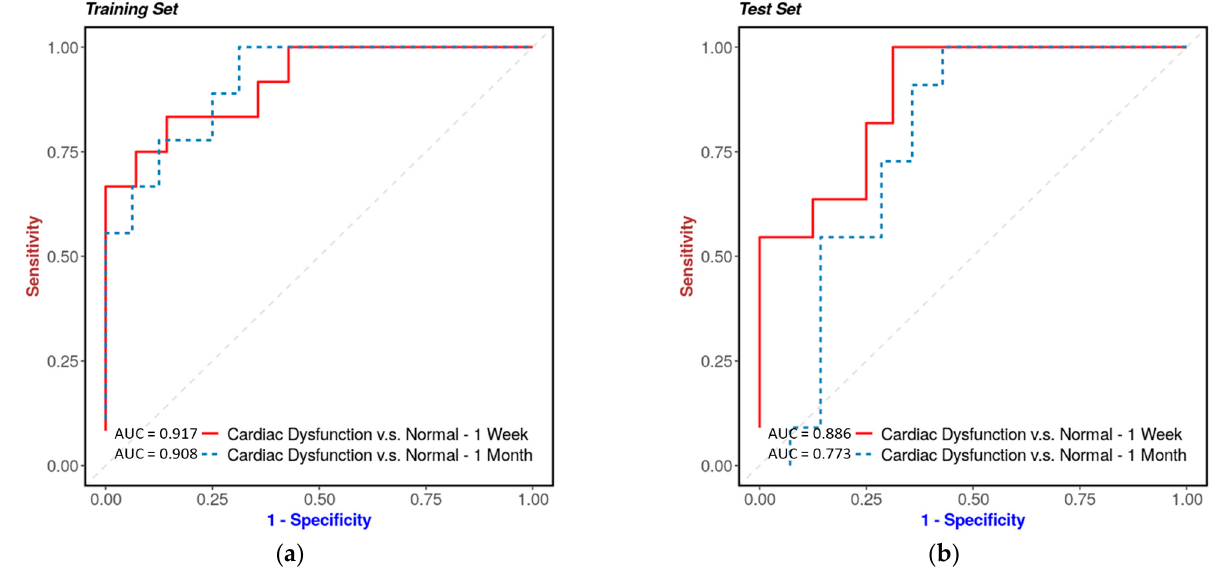
Figure 5. Urinary metabolite predictors of cardiac dysfunction. The prediction of cardiac dysfunction using urinary metabolite predictors developed through logistic regression modeling. A cohort of 50 mice, including 33 wild-type and 34 APCHi mice exposed to radiation, had their cardiac dysfunction outcomes measured, with 18 mice showing normal results and 32 mice displaying signs of cardiac dysfunction. The data were split into a 1:1 ratio for training and testing sets. The 1-week model panel included SM(22:0), homocysteine, TAG56:7-FA20:4, FFA(16:1), and SM(24:0), while the 1-month model panel consisted of anthranilic acid, TAG54:4-FA16:0, CE(22:6), spermidine, and mesaconic acid. Cross-validation was used to calculate true positive rates and false positive rates, and a ROC curve for training set (Panel a ) and testing set (Panel b ) was drawn to estimate the model’s performance. Table 1. Fold Changes and Test Statistics of Key Metabolites in the 1-Week and 1-Month Regres- sion Models. 1 Week Regression